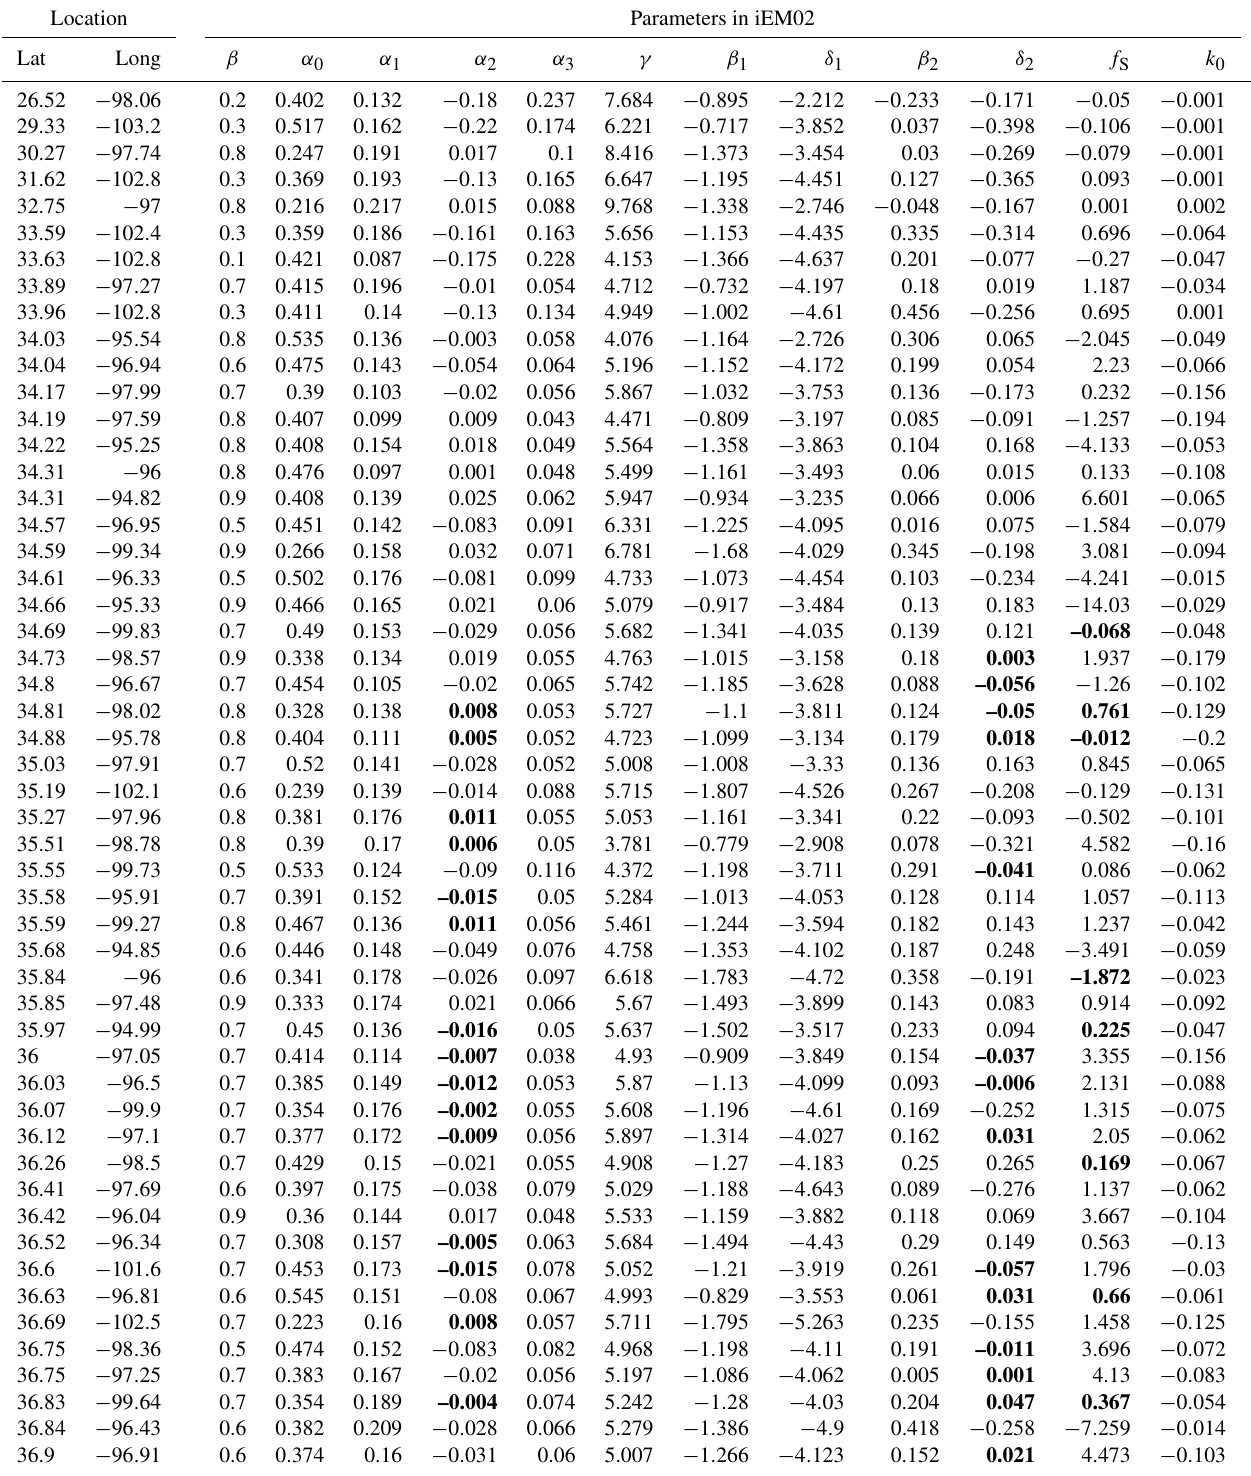
Table A3. List of model parameters for each weather station in the USA Great Plains. The location consists of latitude (Lat) and longi- tude (Long). There are 12 parameters in the improved EM model, including parameters of air temperature ( β ; –); parameters for current day to the previous 3d of T env , including α 0 (–), α 1 (–), α 2 (–), α 3 (–), and constant offset γ (degrees Celsius); annual and semi-annual waves of sine and cosine functions parameters are β 1 , β 2 , δ 1 , and δ 2 (degrees Celsius); and parameters for the snow depth damping factor ( f S ; meters) and the soil damping factor ( k 0 ; –). The bold font indicates that estimated coefficients are not statistically significant at 95% confidence